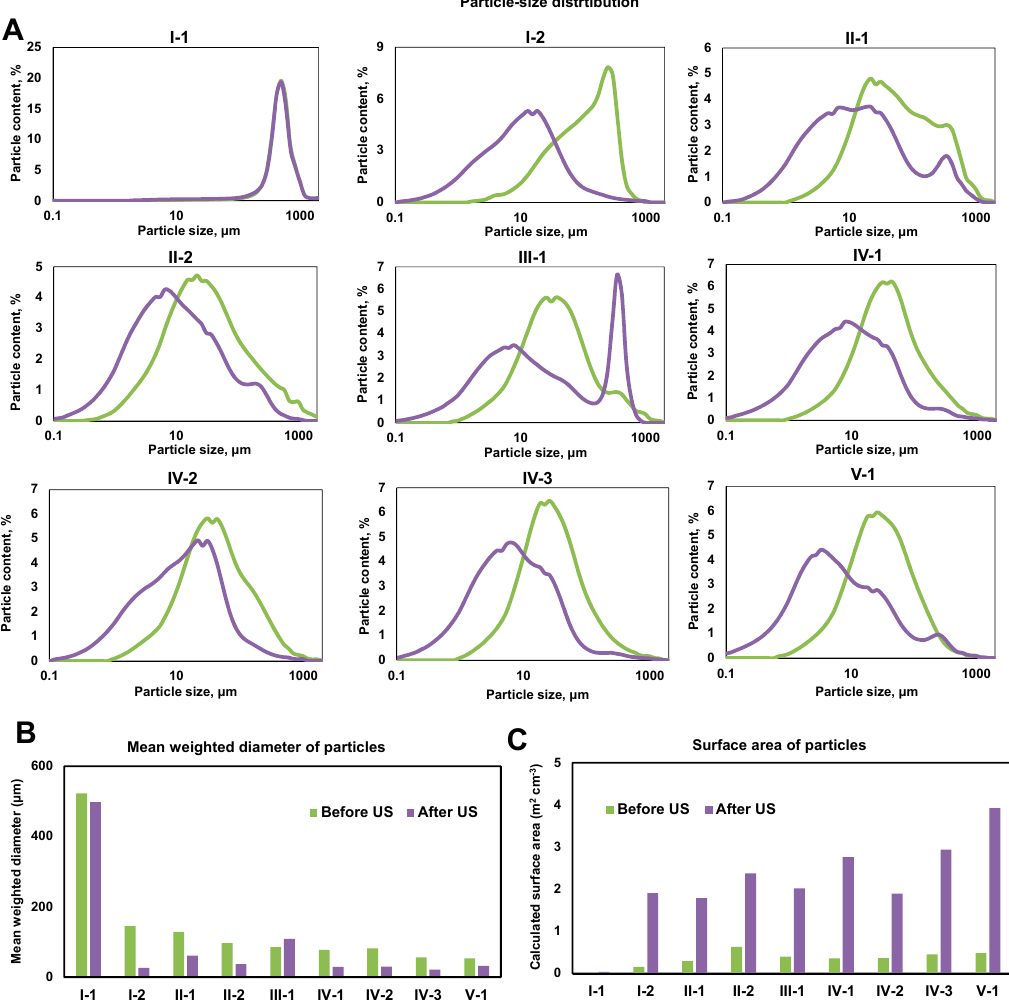
Figure 3. Physical composition of particles in sediments of di ff erent zones of the constructed wetland. ( A ) particle size distribution before and after ultrasonic; ( B ) mean weighted diameter of particles; ( C ) surface area of